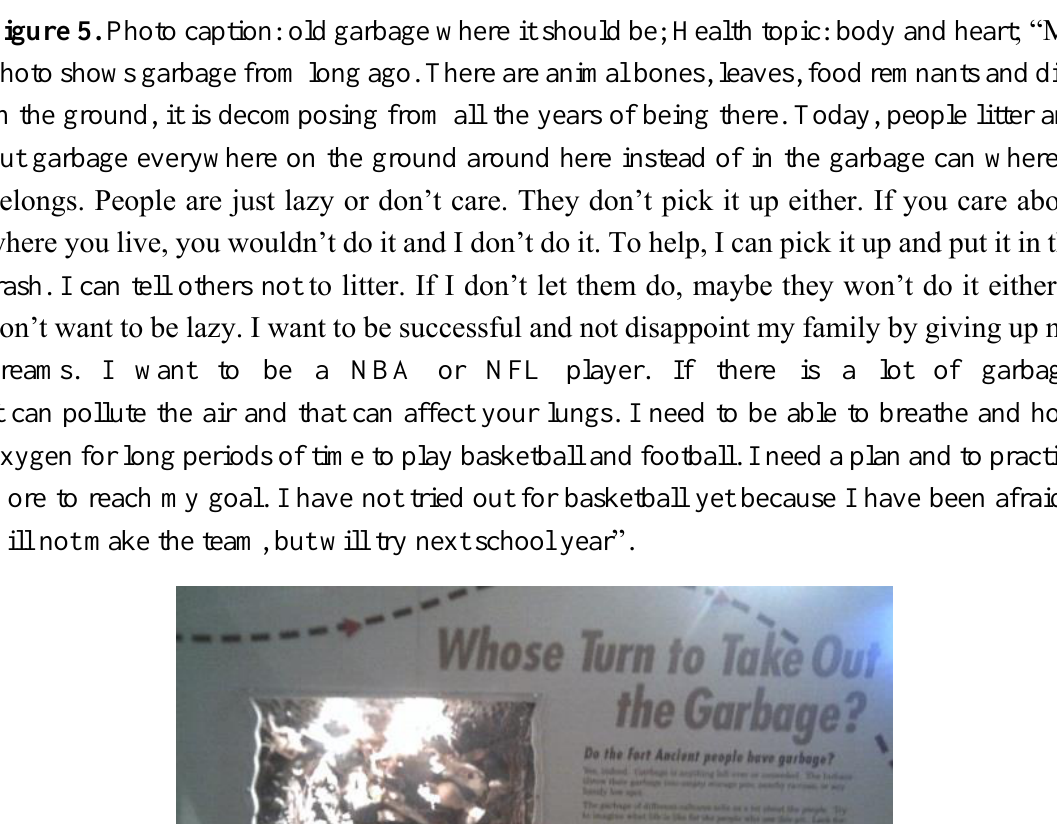
Figure 5. Photo caption: old garbage where it should be; Health topic: body and heart; “My photo shows garbage from long ago. There are animal bones, leaves, food remnants and